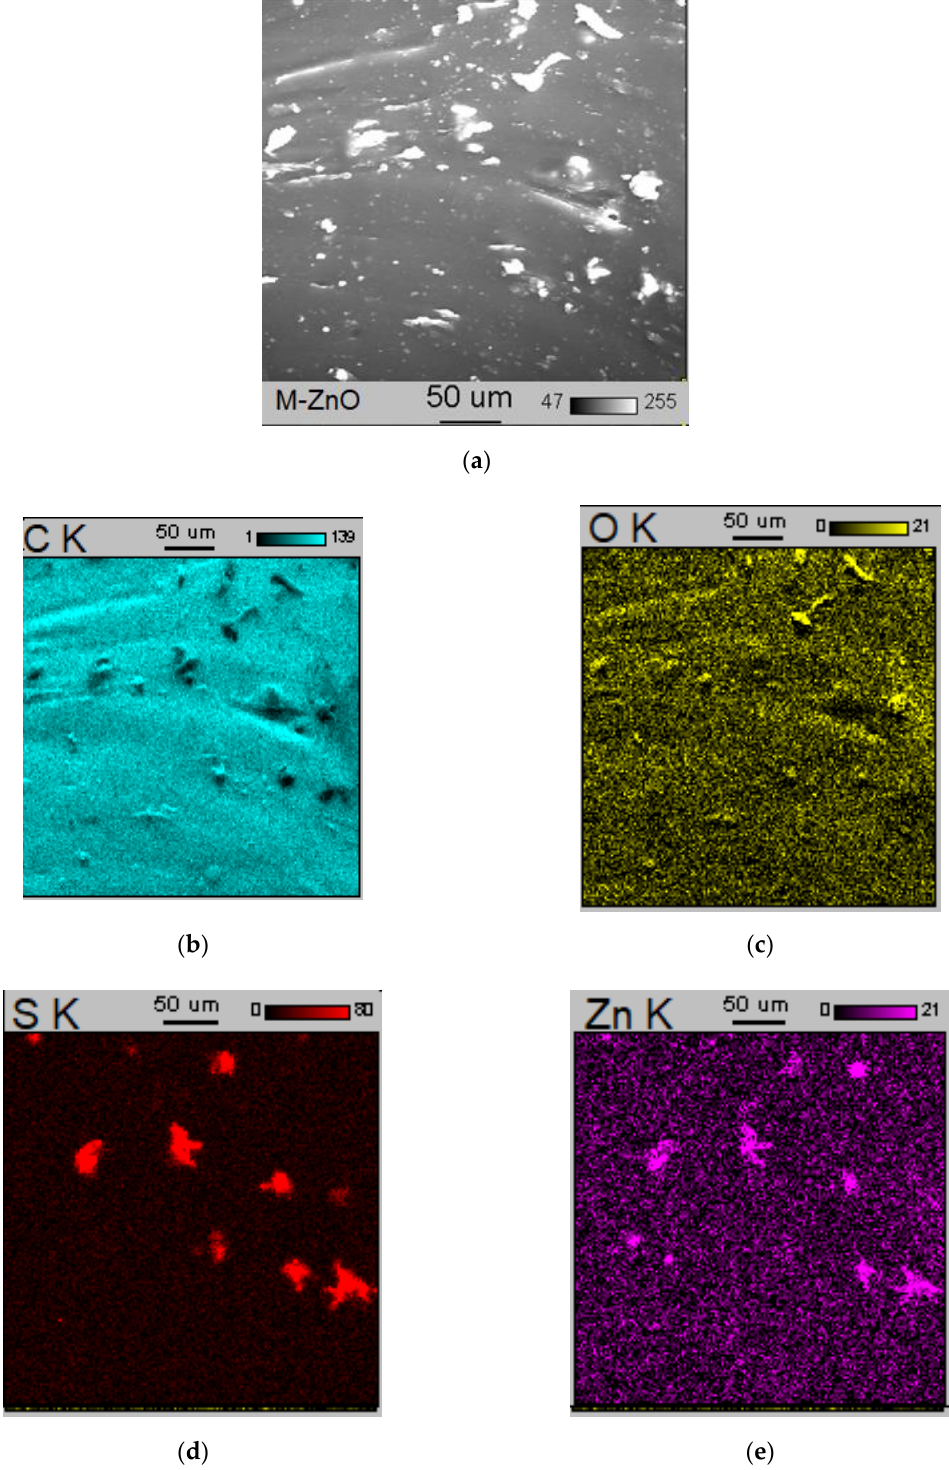
Figure 8. Scanning electron microscopy (SEM) image and Energy-dispersive X-ray spectroscopy (EDS) maps for SBR vulcanizate containing M-ZnO: ( a ) SEM image; ( b ) EDS map for C; ( c ) EDS map for O; ( d ) EDS map for S; ( e ) EDS map for Zn.